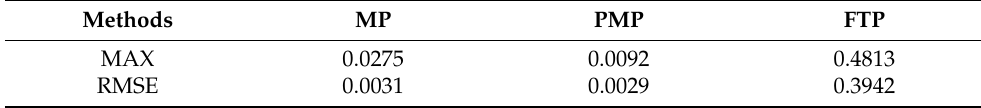
Table 1. Comparison of experimental